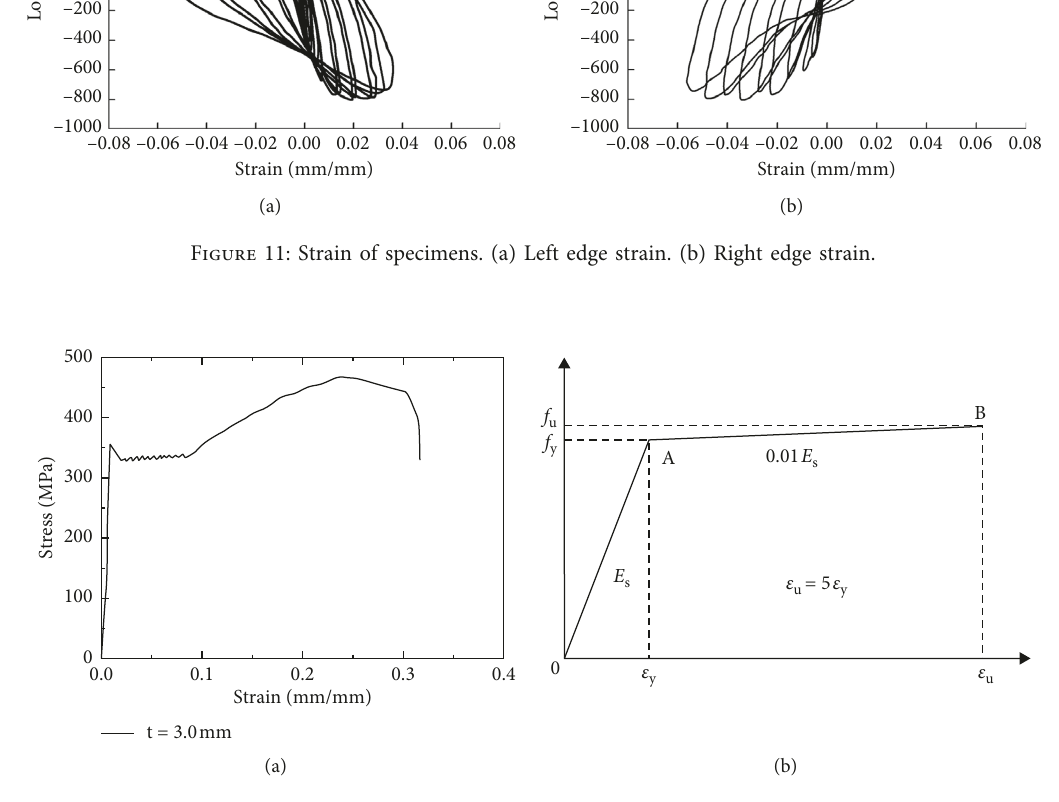
Figure 12: (a) Stress-strain of steel plate. (b) Stress-strain of constraining bolt and